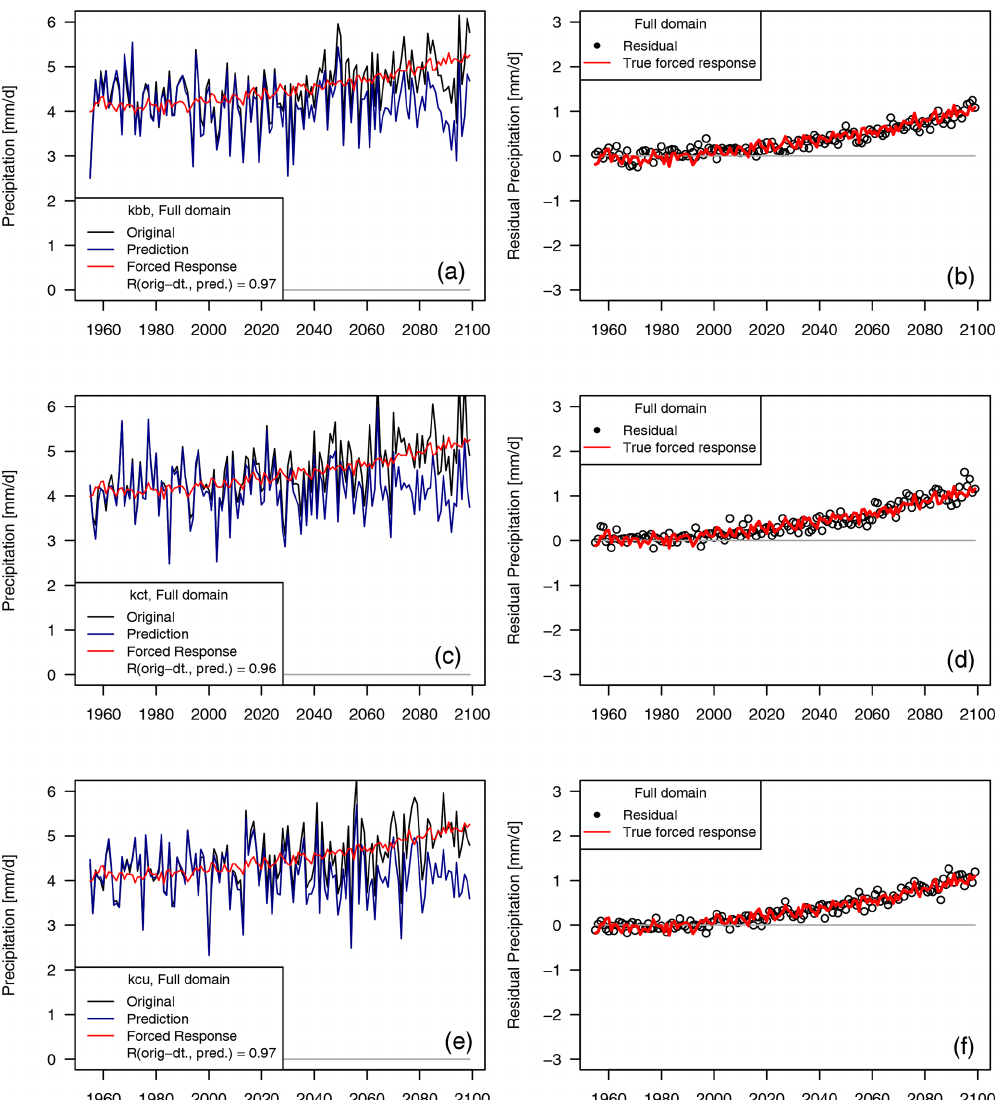
Figure B3. Dynamical adjustment of the full domain (land grid cells only) but training only based on 1955–2020. (a, c, e) Seasonal precip- itation totals simulated by three members of the high-resolution RCM in black ( a : “kbb”, c : “kct”, e : “kcu”), the predicted (“circulation- induced”) component for three “holdout” ensemble members (blue), and the forced response (average across all 50 members, red). (b, d, f) Residuals from the prediction (black dots) and the forced response